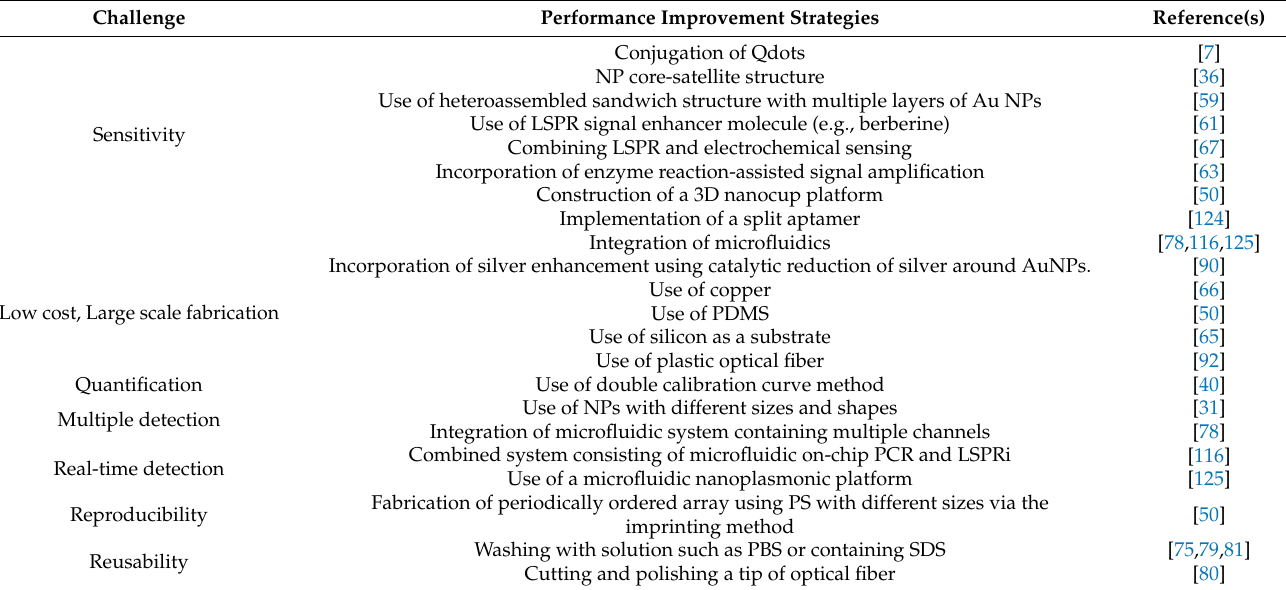
Table 2. Challenges and strategies to improve the performance of LSPR biosensors for the detection of various molecules a . Challenge Performance Improvement Strategies Reference(s)